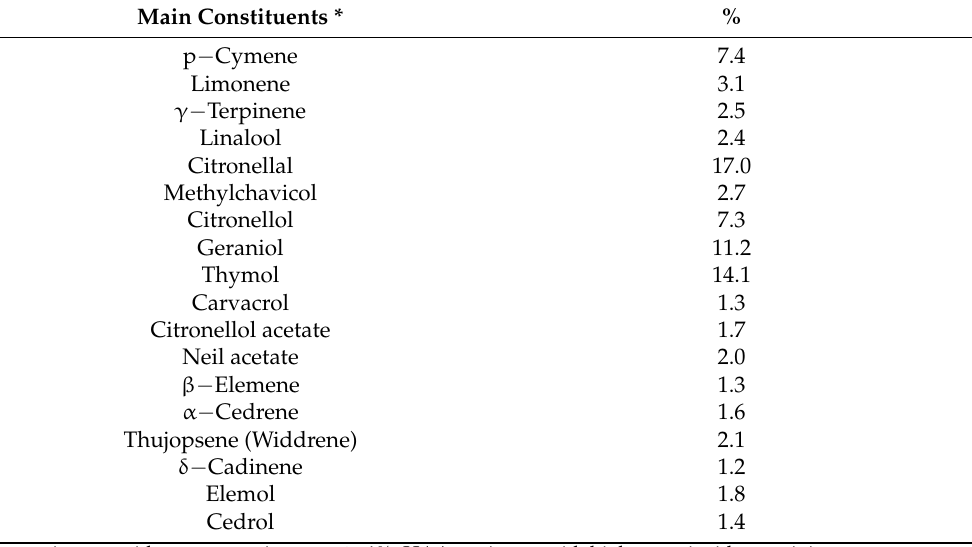
Table 2. The main constituents of